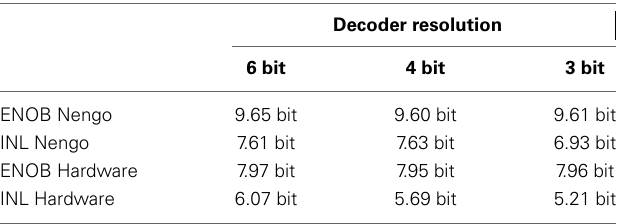
Baseline hardware characteristic, but with 128 neurons.